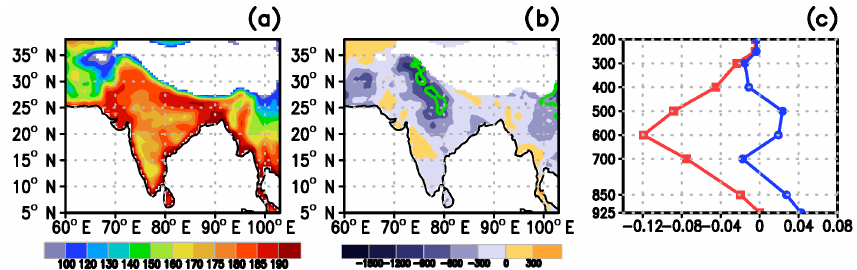
Figure 12. (a) Seasonal average (JJAS) of vertically integrated moist static energy (VIMSE; surface – 500hPa) in PLC experiment (in 1 × 10 4 kJkg − 1 ; 1982–2008). (b) Difference (PLC–HLC) in VIMSE (in kJkg − 1 ; 1982–2008). Green contour shows differences significant at the 90% confidence level. (c) Difference (PLC–HLC) in CI-averaged moist static energy (MSE; in red) and dry static energy (DSE; in blue) in units of 1 × 10 3 kJkg − 1